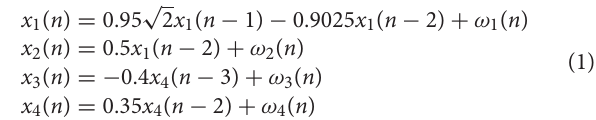
and Constructing within-group effective connectivity graph were conducted to the toy